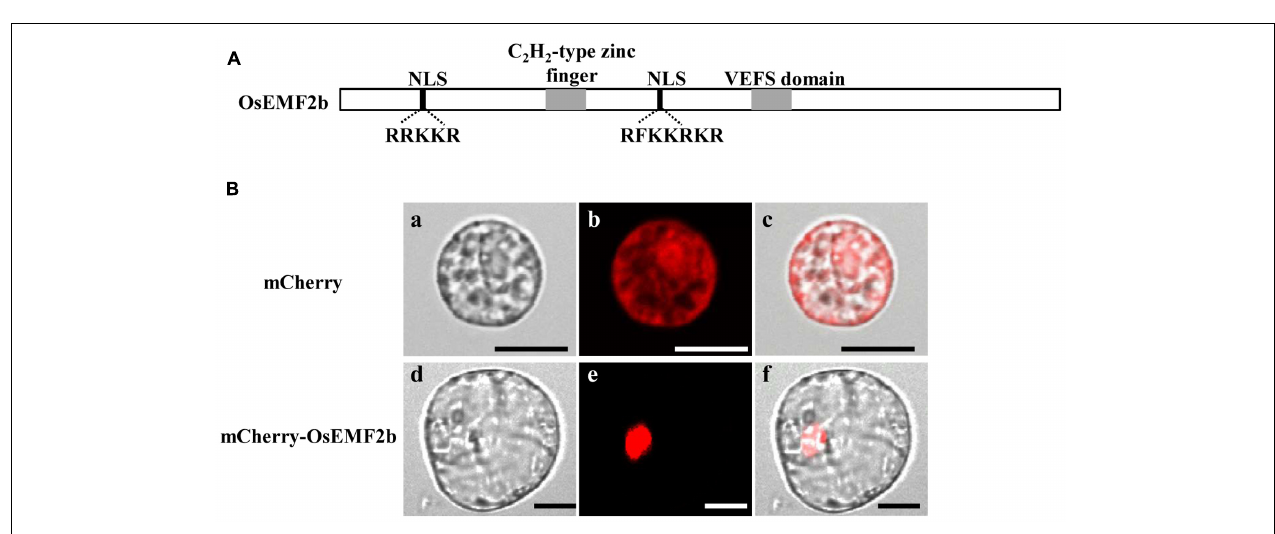
FIGURE 4 | RNA in situ analysis of OsEMF2b. (A) A wild type anther at the meiosis stage showing OsEMF2b expression in microsporocytes, tapetum and connectives of anther. (B) A wild type anther at the young microspore stage showing stronger OsEMF2b expression in tapetal cells, and weaker expression in microspores and connectives of anther. (C) A wild type anther at young microspore stage with the sense probe. Ms, microsporocyte; T, tapetum; Msp, microspore; Vb, vascular bundle of anther connective. Bars = 15 µ m.